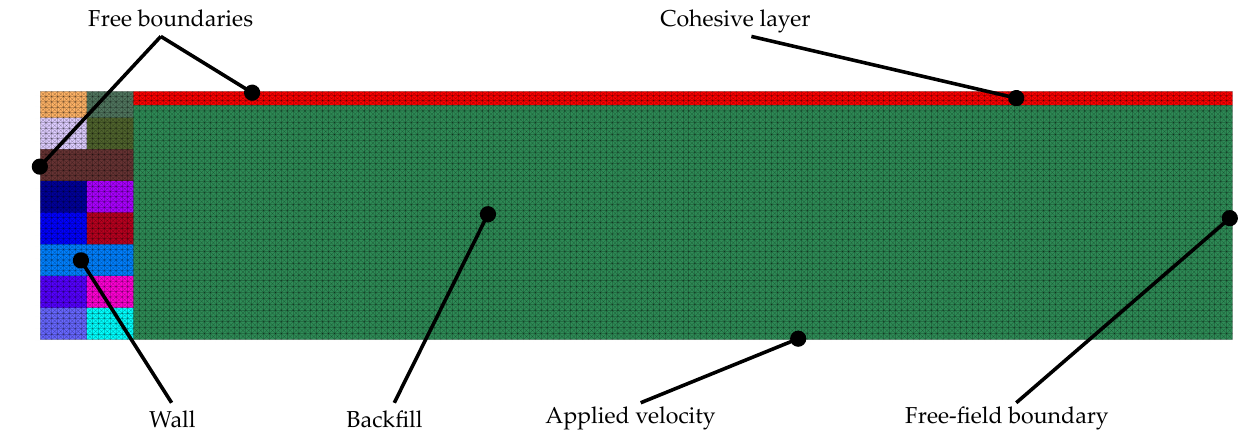
Figure 1. UDEC model of the experiments (see Section 3). The different boundary conditions are